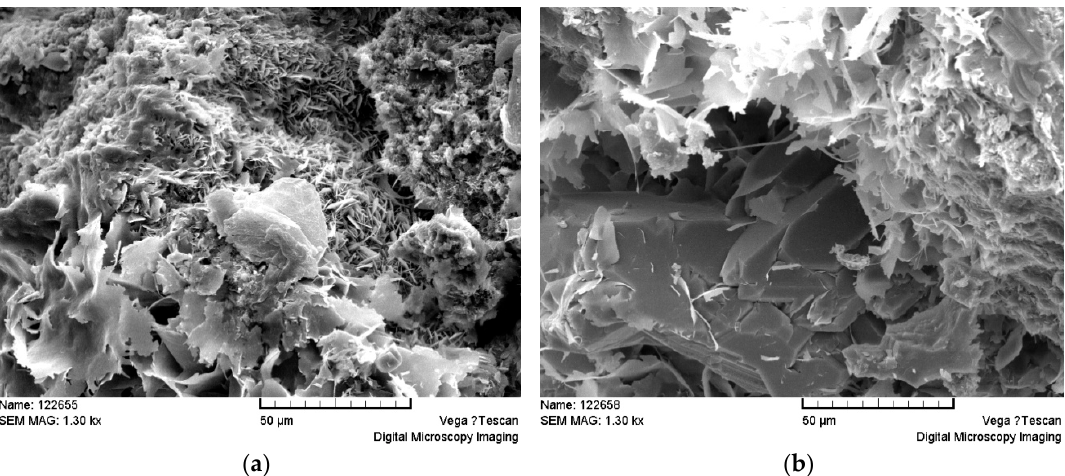
Figure 7. Scanning electron microscope image of tight sandstone cores: ( a ) Intragranular chlorite, illite; ( b ) Quartz, mixed illite/smectite.